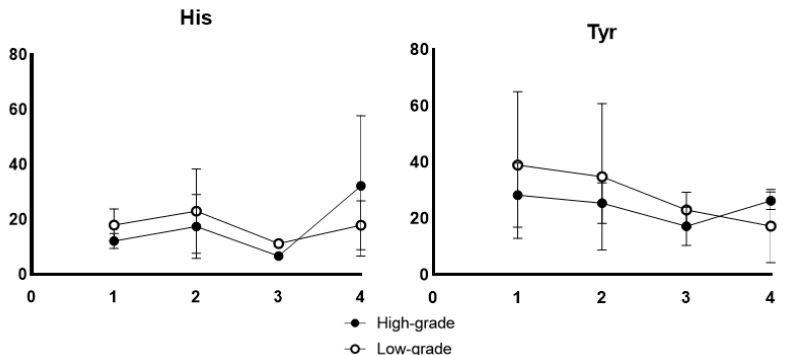
Figure 5. Time course of His and Tyr showed the same tendency in the analysis in which the irradiation field was unified in the oropharynx and oral cavity. ( n = 4, No.3, 4, 5, 9)) The x -axis indicates the sampling point described in Figure 1. The y -axis indicates the concentration of each metabolite ( μ M).